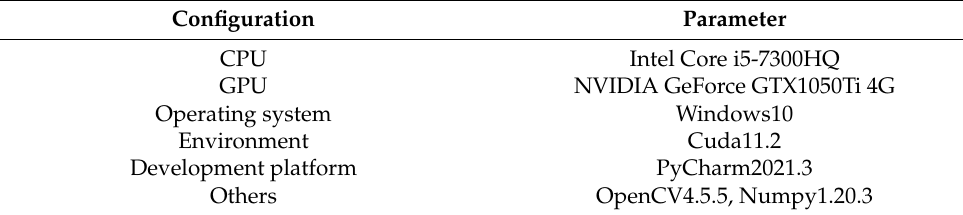
Table 2. Experimental environment.